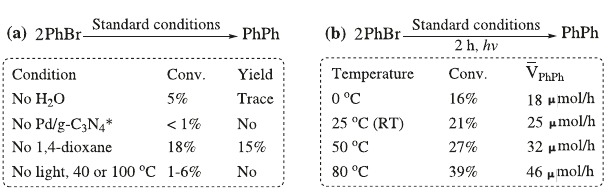
Fig. 7 | Several control experiments. a Investigation on the necessity for using water, Pd/g-C 3 N 4 *, 1,4-dioxane, and light. PhBr: bromobenzene, PhPh: biphenyl, Conv.: conversion of bromobenzene, Yield: yield of biphenyl. b Effect of tem- peratureon the reaction. (cid:1) V PhPh : the average rate of biphenyl production in 2h. For standard conditions, see Fig. 5.